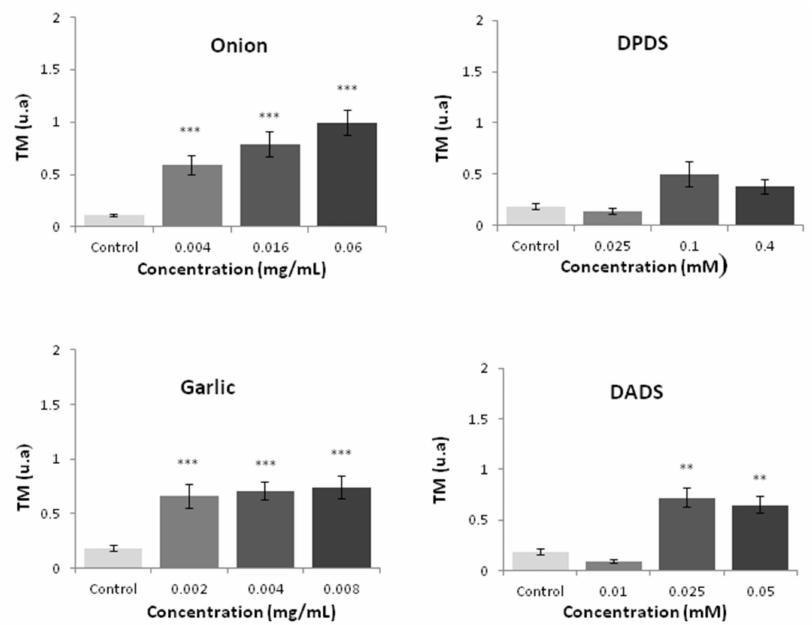
Figure 5. HL60 DNA integrity measured by the comet assay after 5 h of treatment with di ff erent concentrations of the tested compounds. Data are expressed as a TM parameter [54]. Statitiscal significance compared with a negative control: *** p ≤ 0.000 and ** p ≤ 0.01 for mean values of three independent